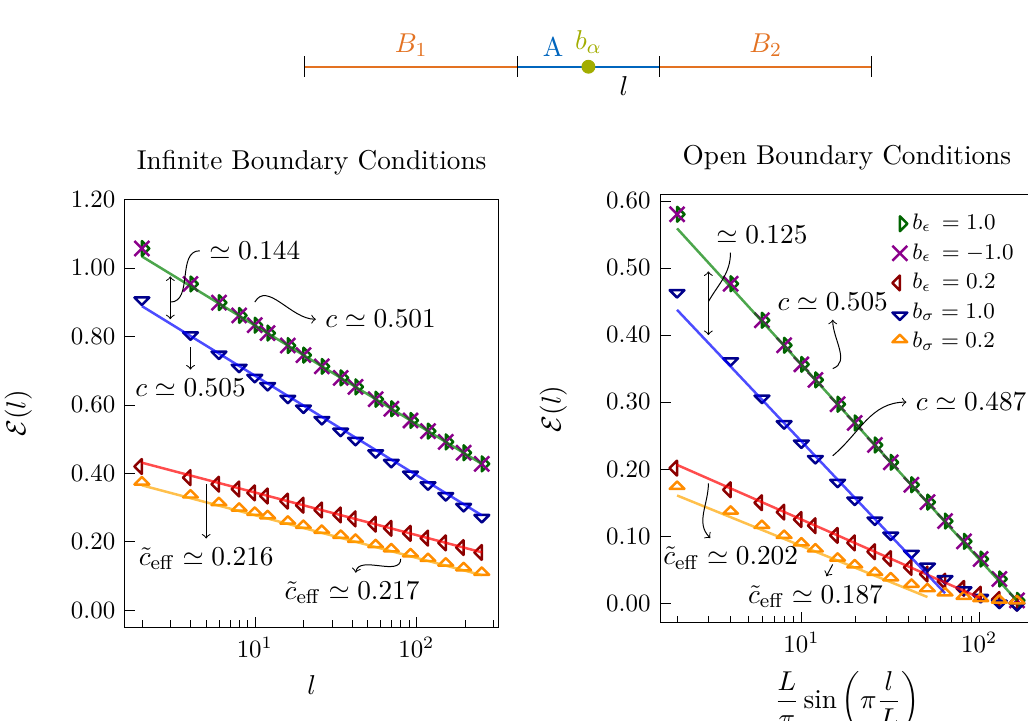
Figure 6 . Scaling of the log-EN, E , for infinite (left) and open (right) bcs. With increasing separation, l , the entanglement between B 1 and B 2 decreases logarithmically [see eq. (4.2)], as is expected from the intuition that correlation function of the degrees of freedom in B 1 and B 2 diminishes algebraically. The effective central charges, ˜ c eff , obtained from the scaling of the log-EN is different from that obtained from the scaling of the interface EE. The fit errors obtained are in the fourth decimal places. Note also that the offset for the duality defects are smaller than those for the energy defects of corresponding strengths. This is in contrast to the corresponding results for the interface EE (see figure 5 and maintext for further discussion). For the duality defect results with open bc, as for the interface EE, the presence of zero energy modes leads to deviations from the logarithmic scaling of the log-EN. This leads to poorer estimates of the effective central charges for the open bc case compared to the infinite